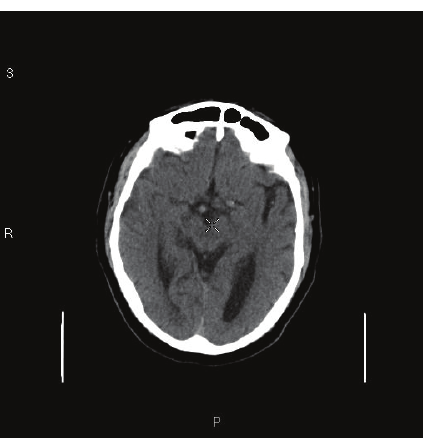
Figure 1: Noncontrast CT scan showing age related atrophy changes.